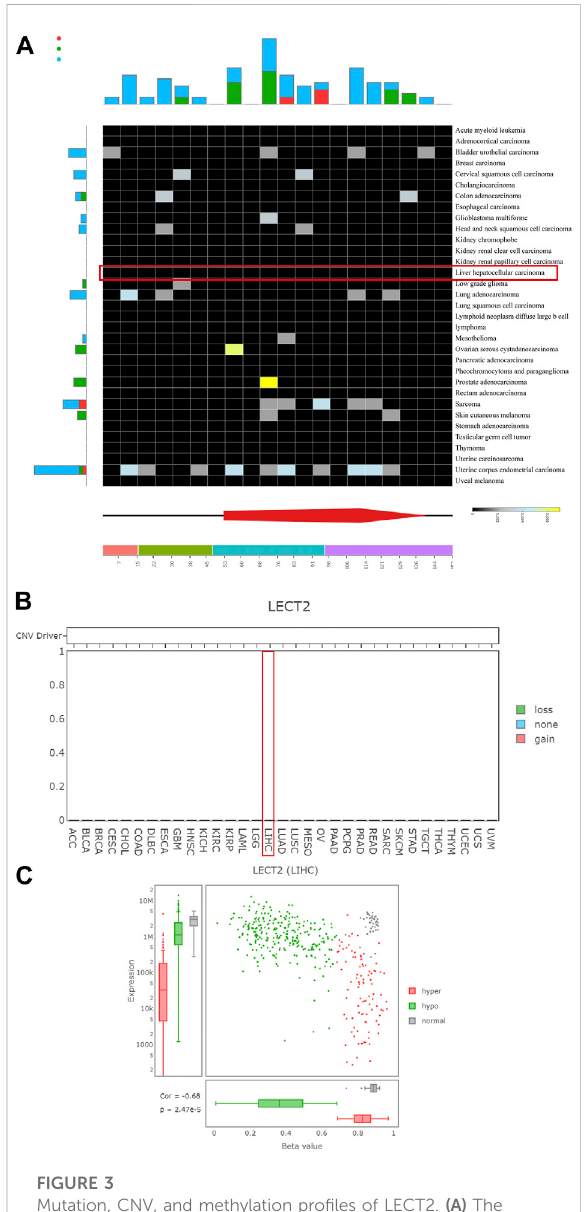
FIGURE 3 Mutation, CNV, and methylation pro fi les of LECT2. (A) The mutation status of LECT2 in various tumors according to the DriverDBv3 database (B) The CNV of LECT2 in various tumors (C) The methylation of LECT2 in